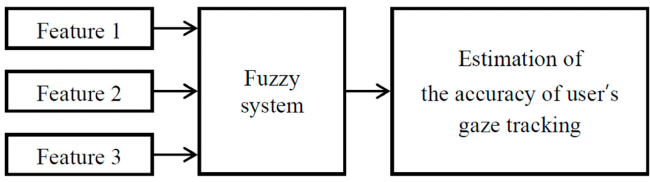
Figure 6. Process of estimating the gaze tracking accuracy of the user by applying a fuzzy algorithm.